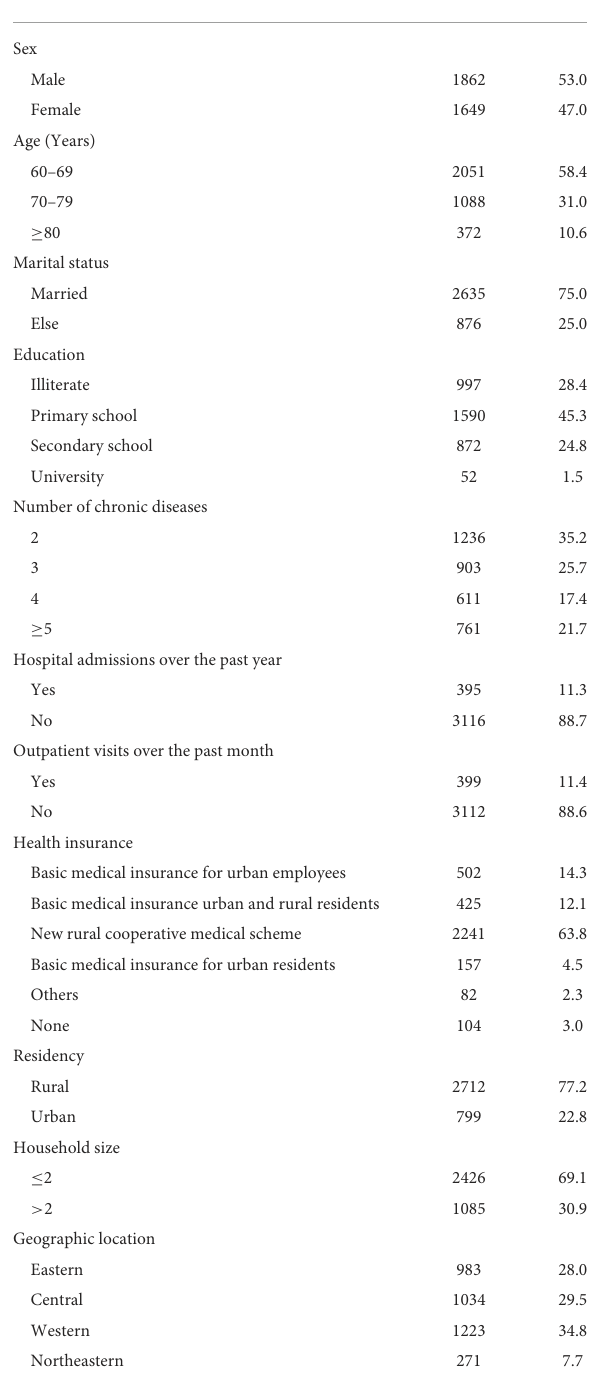
TABLE 1 Sociodemographic characteristics of study participants with multimorbidity ( n = 3511).